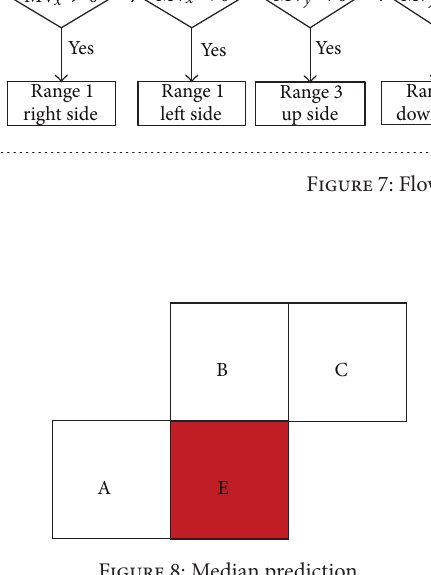
Figure 8: Median prediction.